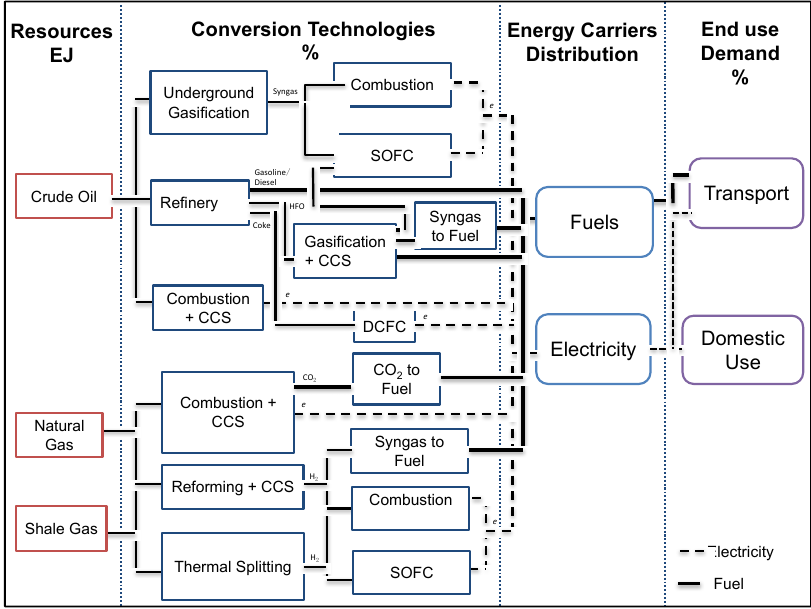
Figure 1. Proposed energy system implemented in our study.